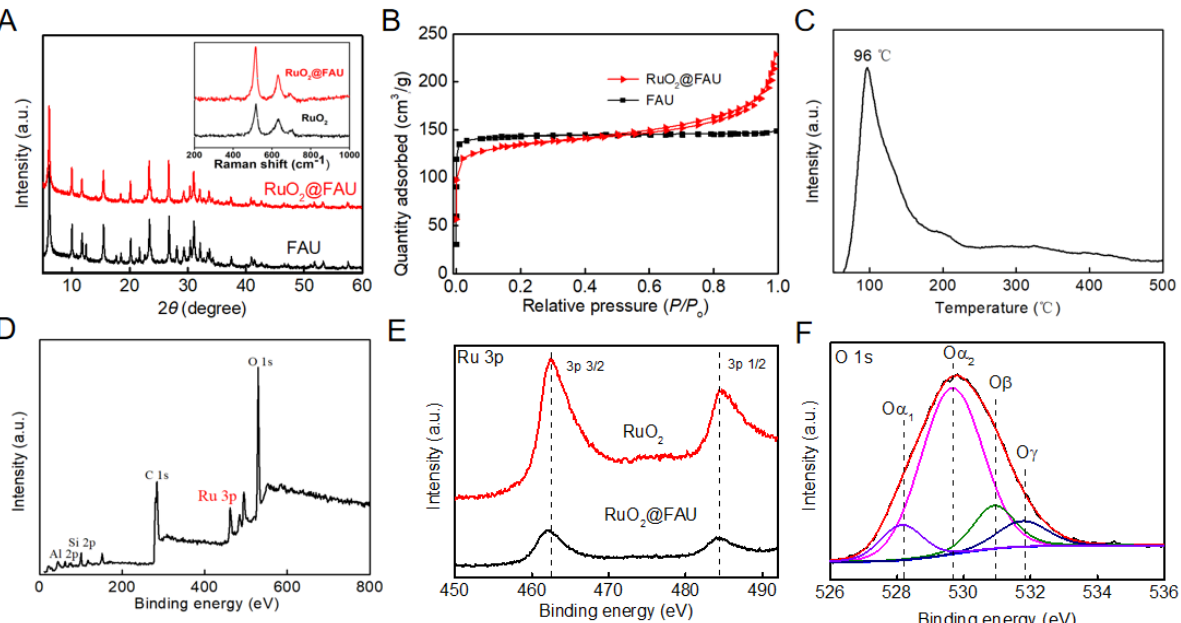
Figure 1. Phase characterizations. ( A ) XRD patterns of FAU and RuO 2 @FAU catalysts, and the